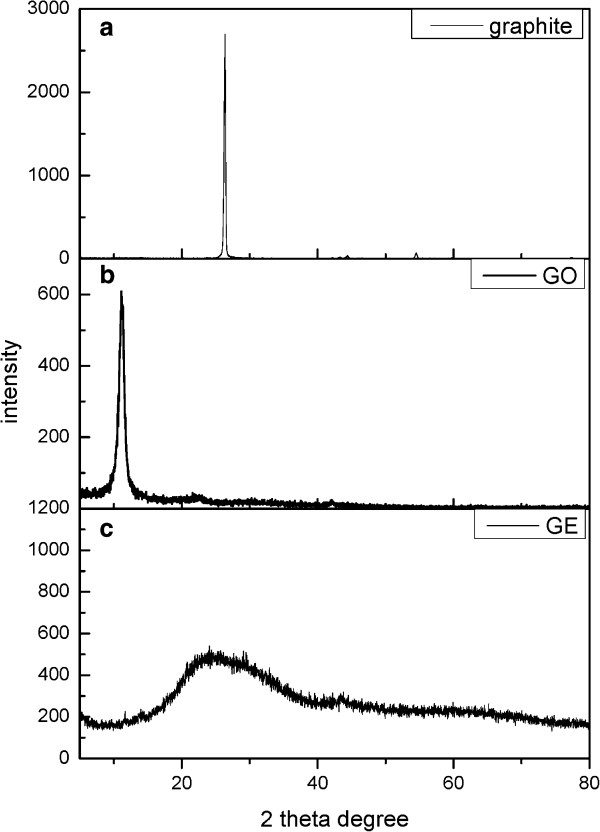
The XRD patterns for (a) graphite as received (graphite), (b) graphite oxide (GO), and (c) graphene (GE), respectively.